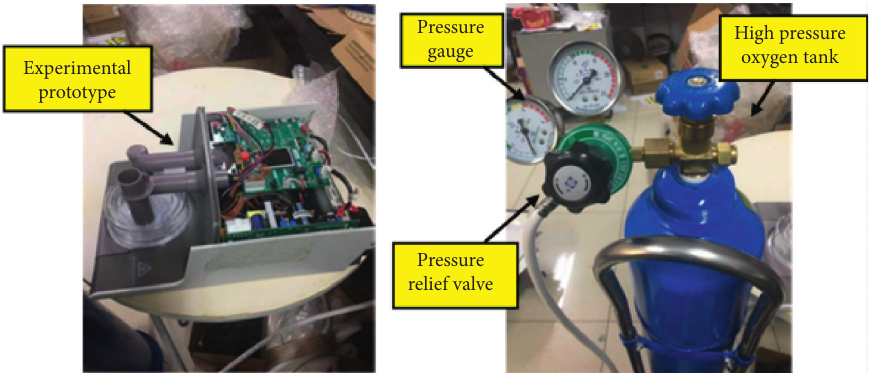
Figure 3: Schematic diagram of prototype